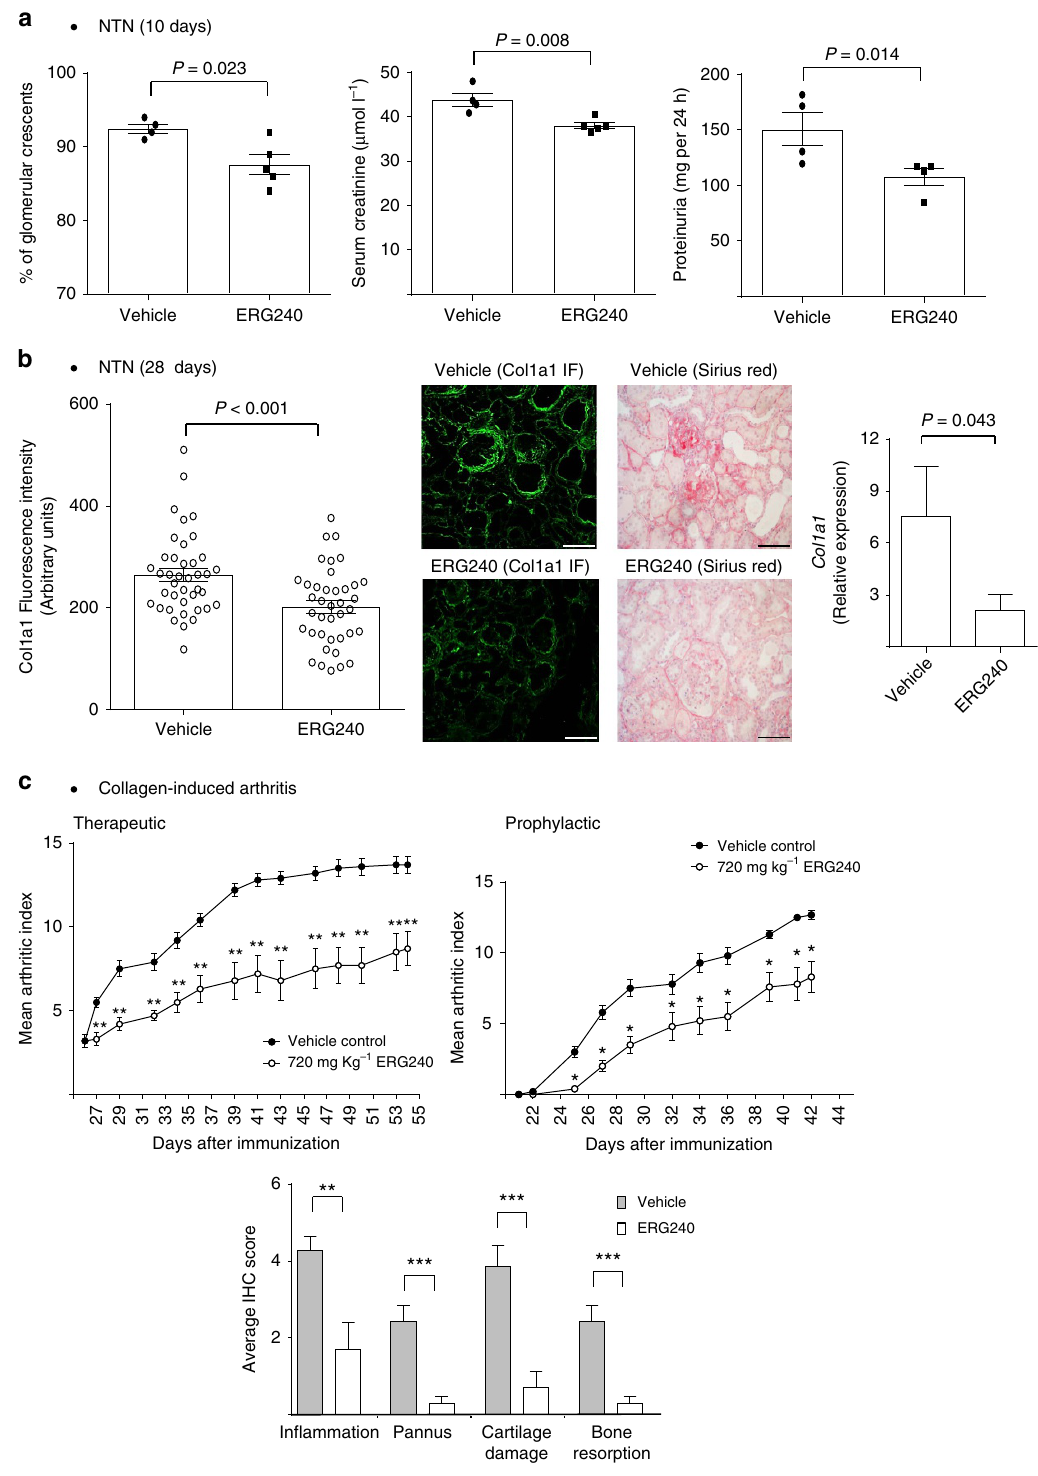
Figure 5 | Orally administrated ERG240 reduced the severity of crescentic glomerulonephritis in rats and CIA in mice. ( a ) Glomerular crescents, serum creatinine, and proteinuria levels measured in vehicle and ERG240 treated rats at day 10 following induction of nephrotoxic nephritis. At least n ¼ 4 rats were used in each group. ( b ) Col1a1 immunofluorescence (IF) quantification (left panel), representative IF and Sirius red staining images (middle panel) and Col1a1 qRT-PCR (normalized to Hprt ) 28 days following NTS injection. Original magnification, (cid:3) 20, at least n ¼ 4 animals were used in each group. ( c ) Clinical progression of CIA measured by the Mean Arthritis Index in vehicle and ERG240-treated animals in both studies (prophylactic and therapeutic, upper panel; at least n ¼ 6 animals per group). Histological analysis of joints from representative whole paws scored for inflammation, pannus formation, cartilage damage and bone resorption (lower panel). Error bars are s.e.m. Either Mann–Whitney or Student’s t -test were used for significance. *** P o 0.001, ** P o 0.01, * P o 0.05. Scale bars, 50 m